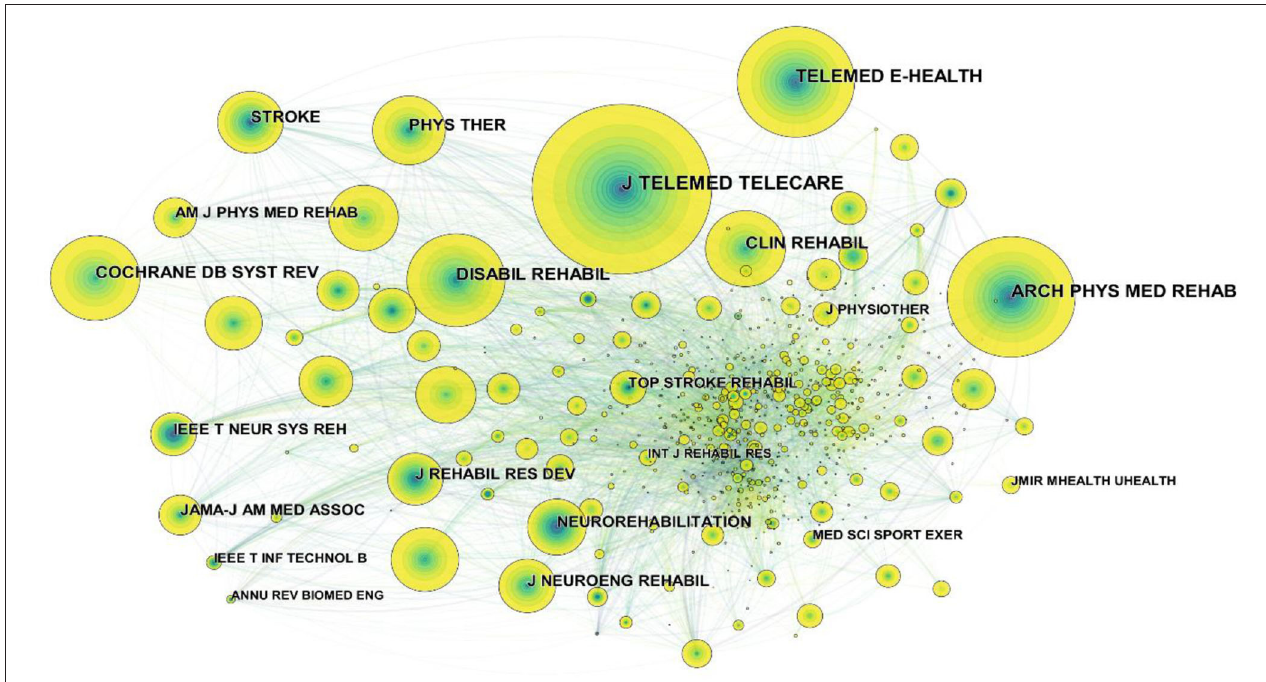
FIGURE 2 | Map of cited journals for telerehabilitation from 2000 to 2021.